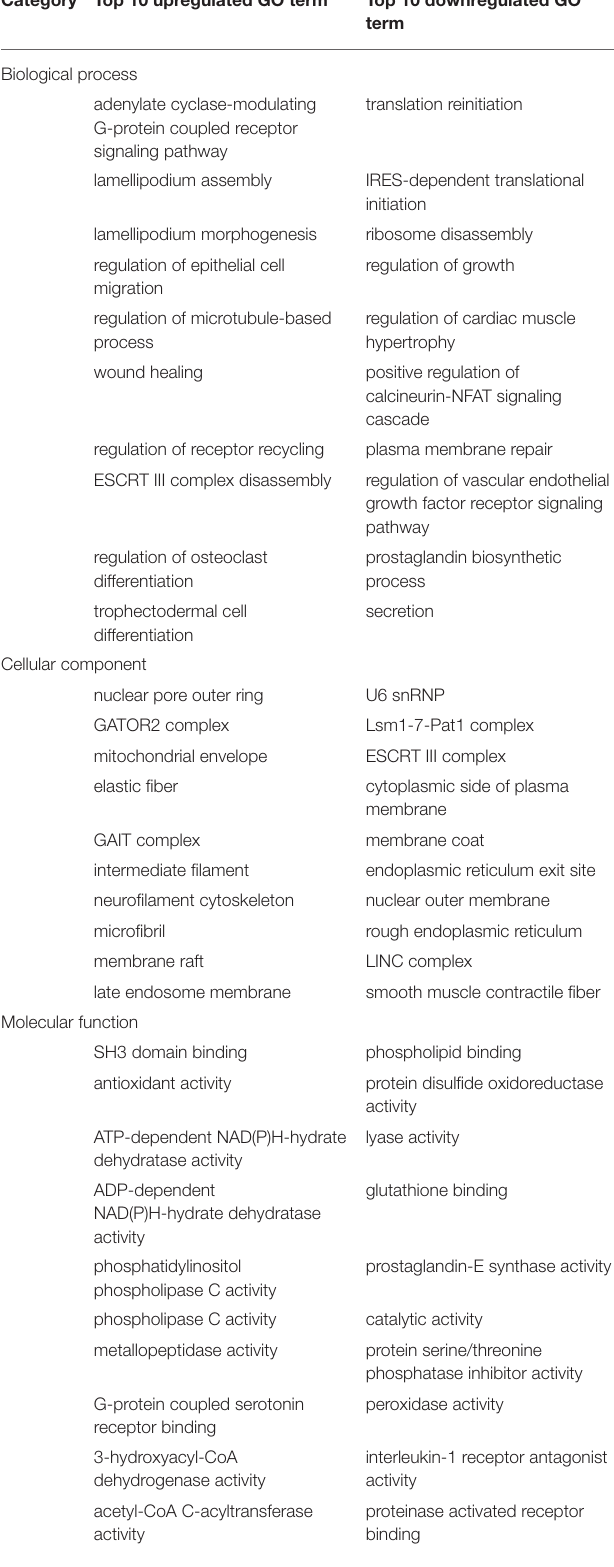
TABLE 1 | Top 10 GO term (SDAVF-DV vs STA). Category Top 10 upregulated GO term Top 10 downregulated GO